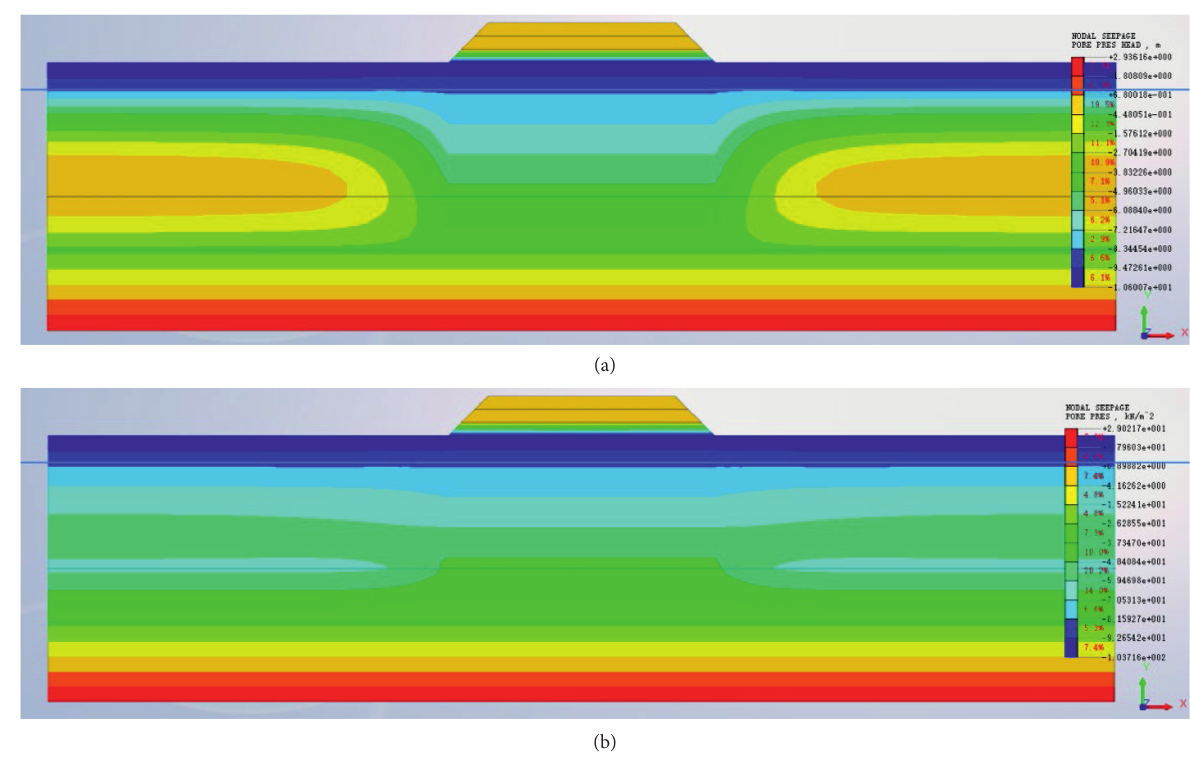
Figure 11: Calculation cloud chart of pore water pressure: (a) PVDs and (b) PHDs.